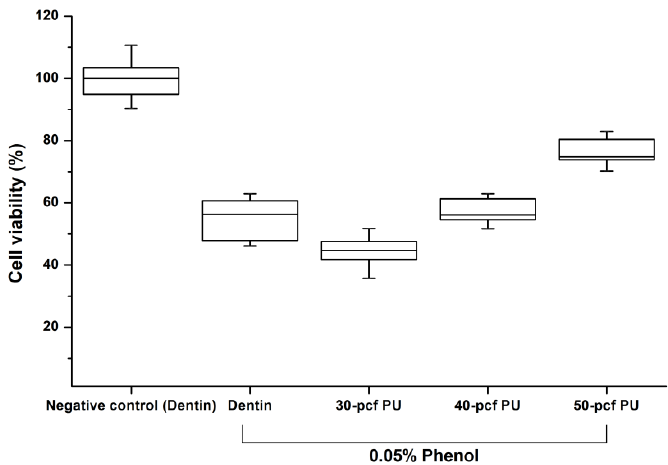
Figure 1. Cell viabilities of 0.05% phenol dilution by bovine dentin or three types of polyurethane discs. This figure shows the cytotoxicity test of 0.05% phenol by bovine dentin or polyurethane discs. Each box in the boxplot graph means the maximum, 75%; median, 25%; and minimum values. Cell viability of negative control (non-treated group)with dentin was set as 100% cell viability. Dentin disc treated by 20 μL of 0.05% phenol made approximately 50% cell viability. The cell viability with polyurethane discs increased according to the increases of disc density ( P < 0.05). The 40-pcf polyurethane disc was not statistically different from natural dentin disc ( P > 0.05). Groups with different letters above the data bar are statistically significant ( P <